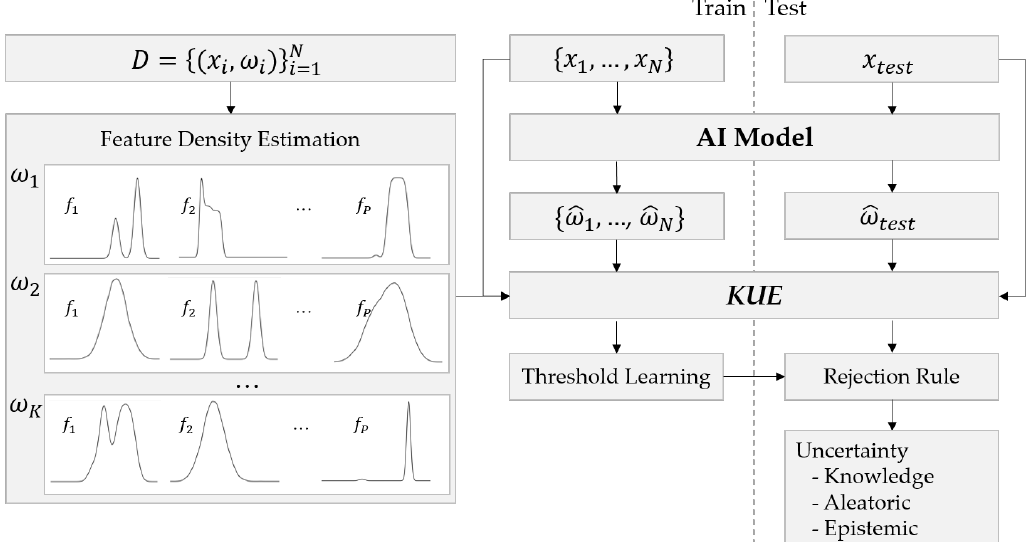
Figure 1. Overview of the main steps of the proposed approach for predictive uncertainty.